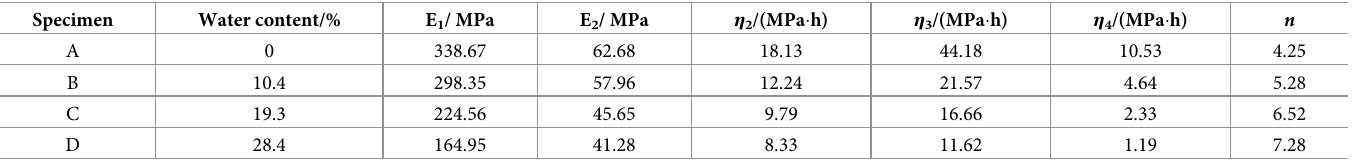
Table 2. Mean values of the parameters of the ageing damage model considering water content. Specimen Water